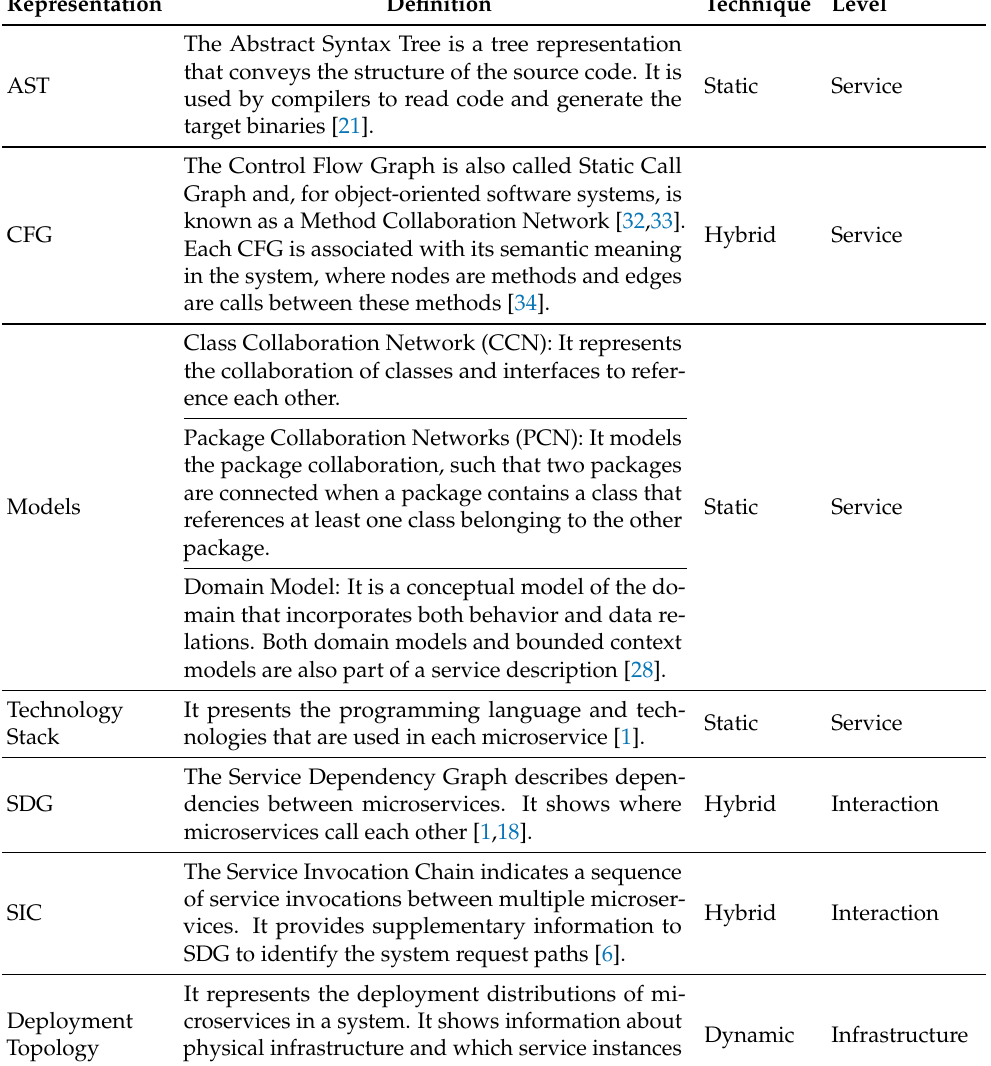
Table 1. Intermediate representations